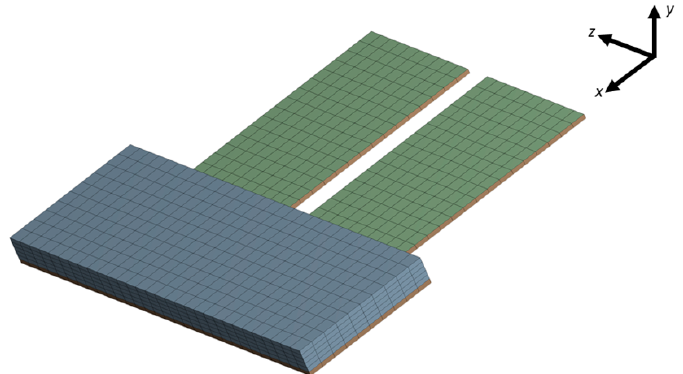
Figure 4. View of the mesh used in finite element method (FEM) models of the PEH devices.